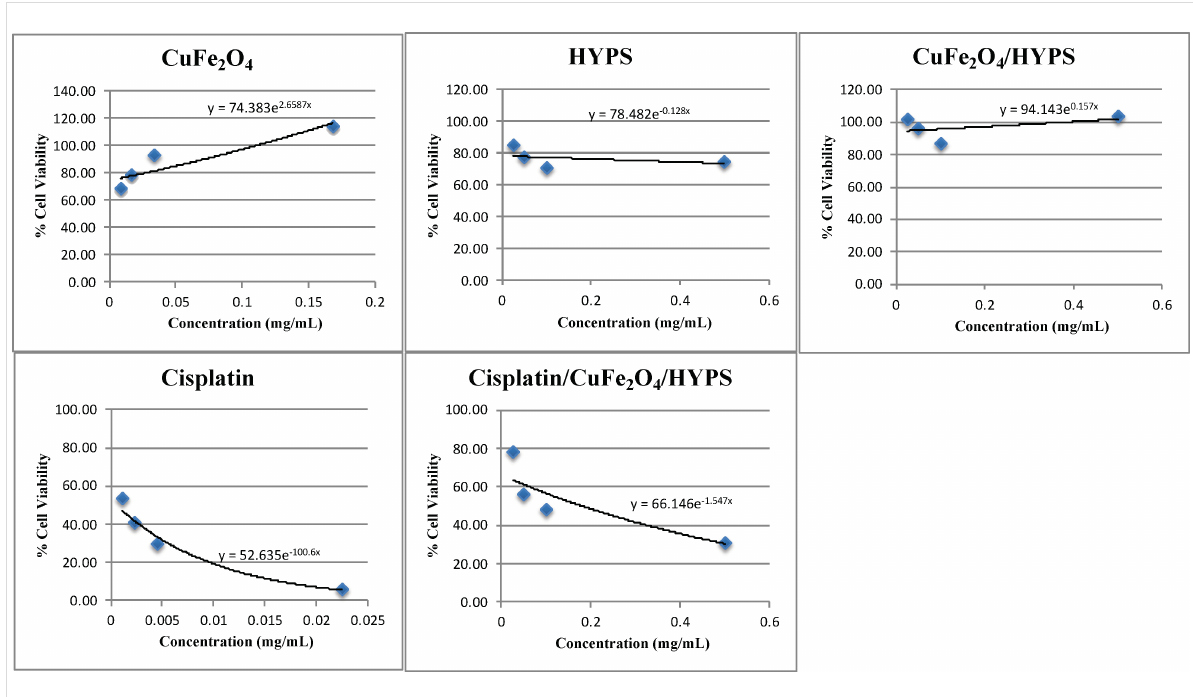
Figure 9: EC 50 values for each condition. Data sets from Figure 8 were used to extrapolate the line equation of each condition: CuFe 2 O 4 , HYPS, CuFe 2 O 4 /HYPS, cisplatin, and cisplatin/CuFe 2 O 4 /HYPS.